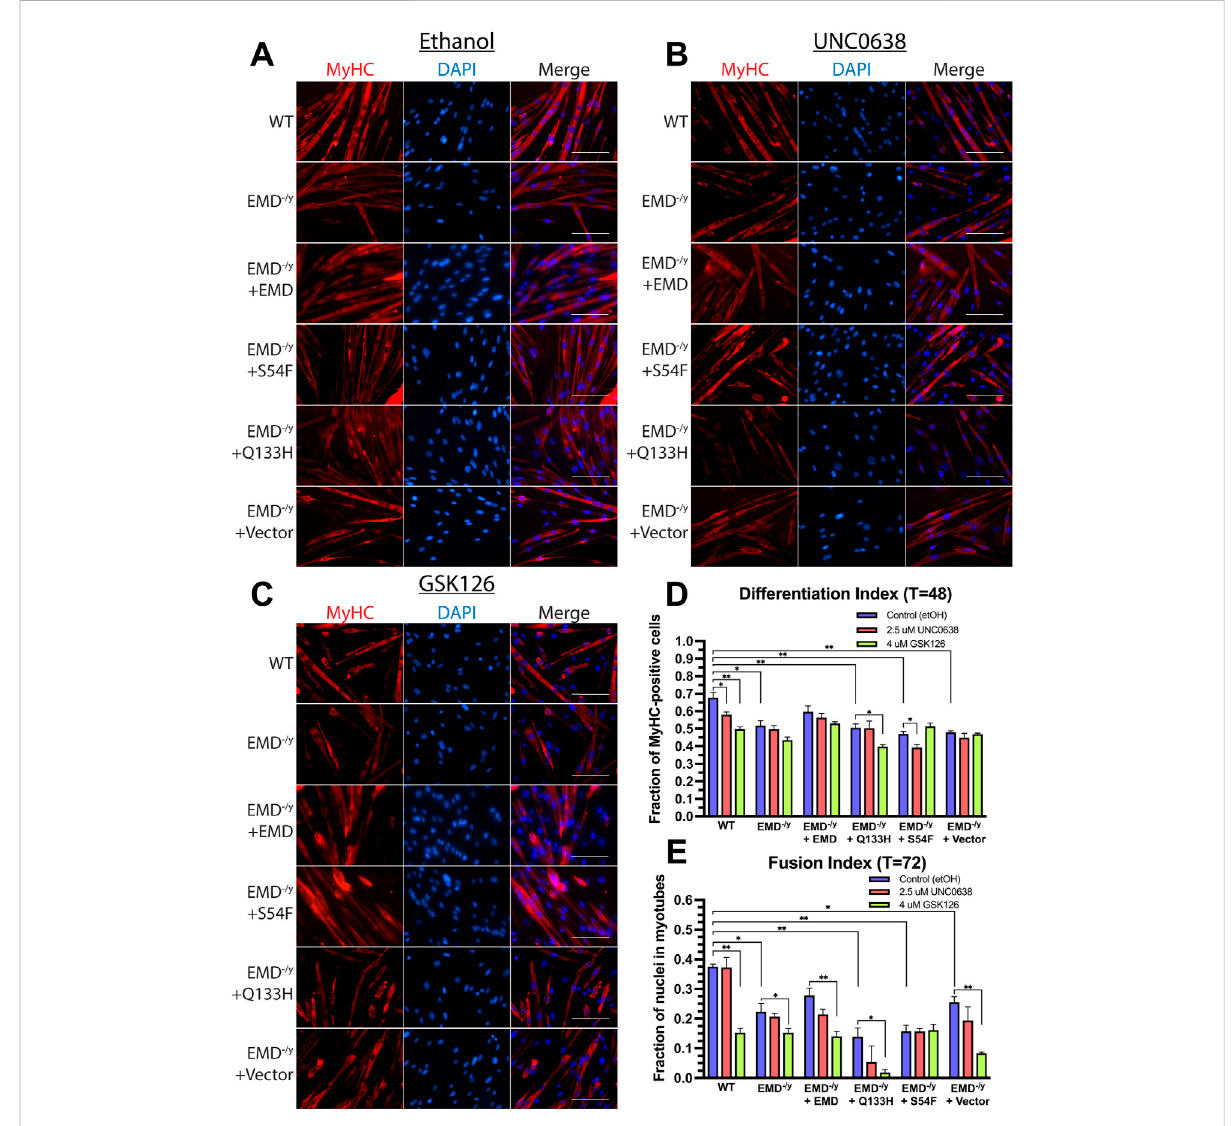
FIGURE 6 Inhibition of G9a and EZH2 fails to rescue emerin-null, S54F, and Q133H myogenic progenitor differentiation, but exacerbates their differentiationdefects.Theindicatedmyogenicprogenitorcelllineswereinducedtodifferentiateinthepresenceofethanolalone (A) ,UNC0638 (B) , or GSK126 (C) for 48 or 72 h. Cells were fi xed, incubated with antibodies against MyHC, and stained with DAPI. The differentiation index (D) is the number of nuclei inMyHC + multinucleated myotubesplus thenumber of nuclei inMyHC mono- ordi-nuclear cells/total nuclei after 48 h. The fusion index (E) is the number of nuclei in MyHC + multi-nucleated myotubes ( ≥ 3 nuclei/total nuclei) after 72 h. Scale bars represent 100 µm. Error bars represent SEM. (Student ’ s t-test; *p < 0.05 **p <